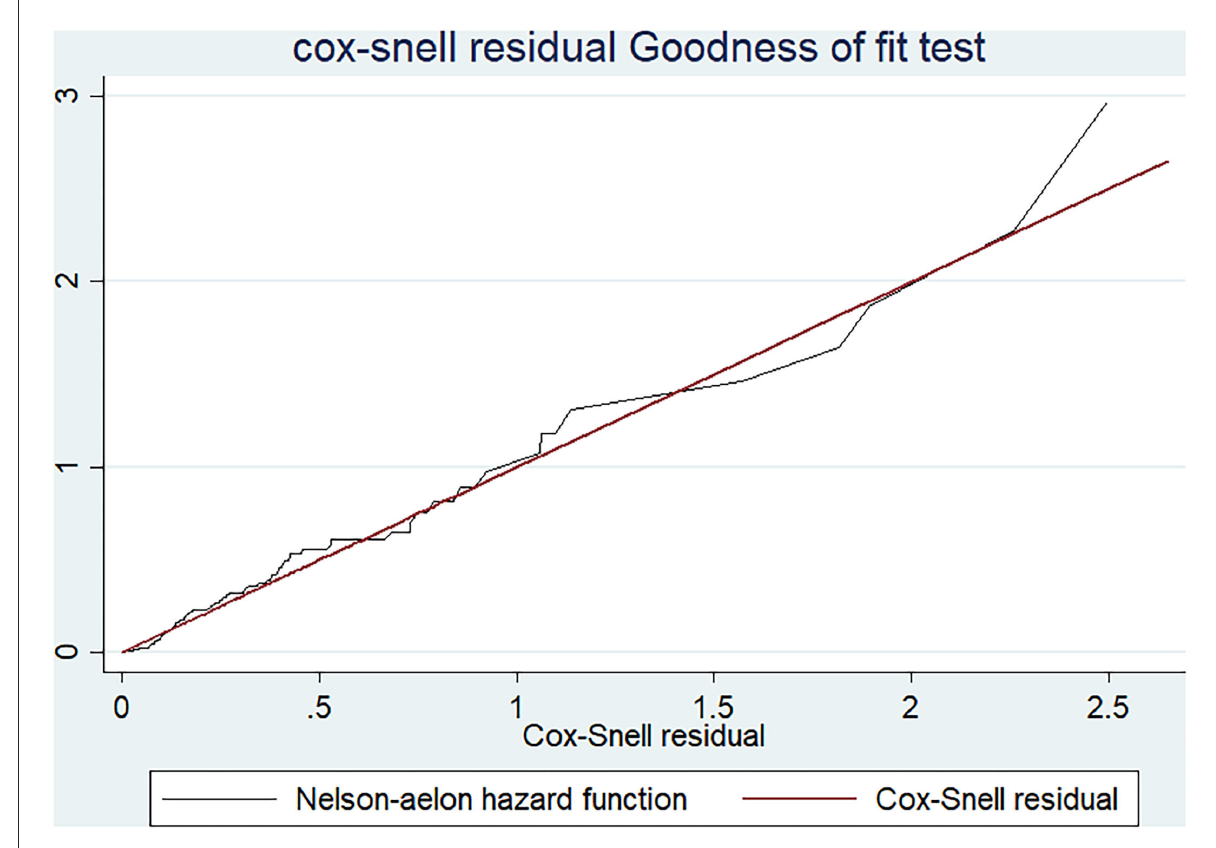
FIGURE4 A graph of Cox-Snell residual test showing overall goodness of fit test result among adults receiving ART in FHCSH, Northwest Ethiopia,